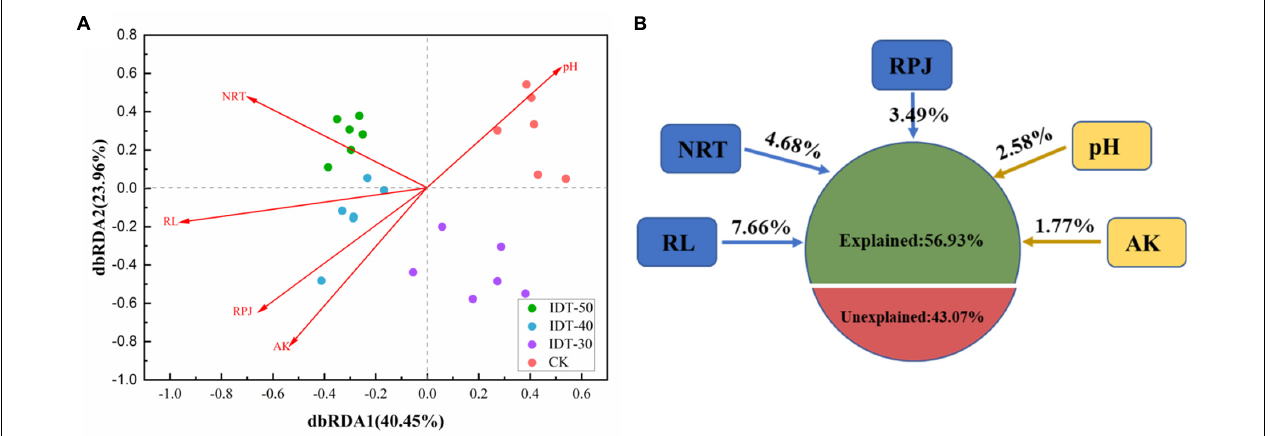
FIGURE 3 | Distance-based (distance = Bray) redundancy analysis (dbRDA) (A) depicting the correlation between bacterial communities and rhizosphere environment, and (B) variance decomposition, with the percentages of variance explained by s soil physicochemical and plant root growth characteristics. AK, available potassium; RPJ, root projection area (cm 2 ); RL, root length (cm); NRT, number of root tip.